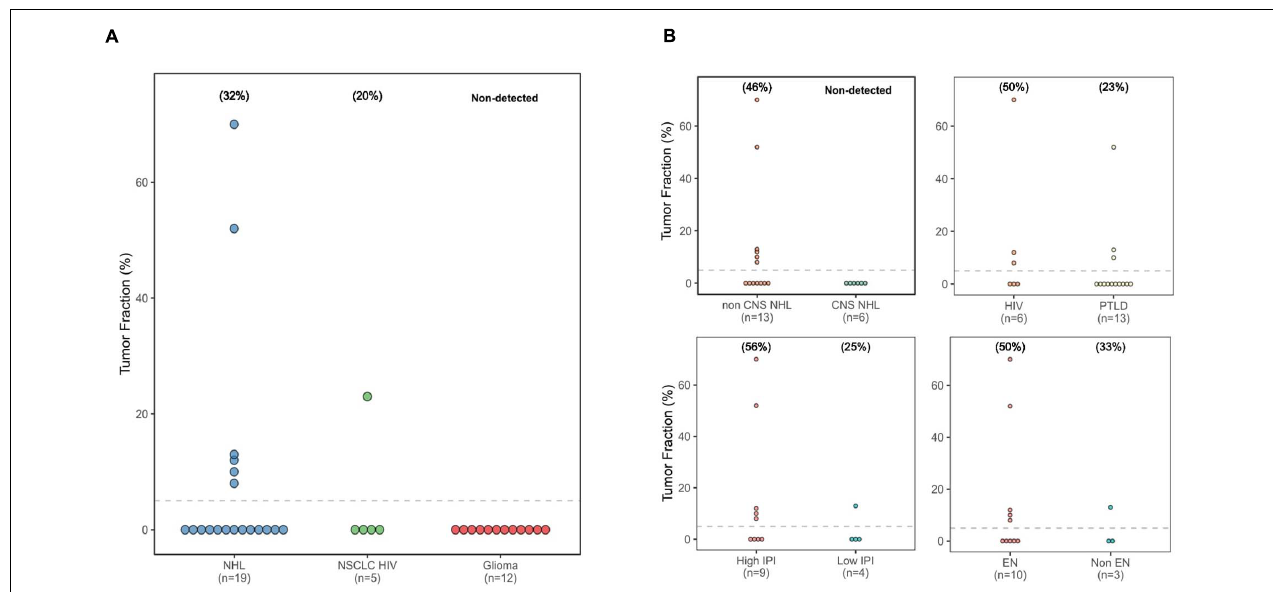
FIGURE 1 | Tumor fraction dot plots. (A) All three cancer types studied. (B) Based on non-Hodgkin lymphoma location, immunodeficiency type, nodal location, and International Prognostic Index group.